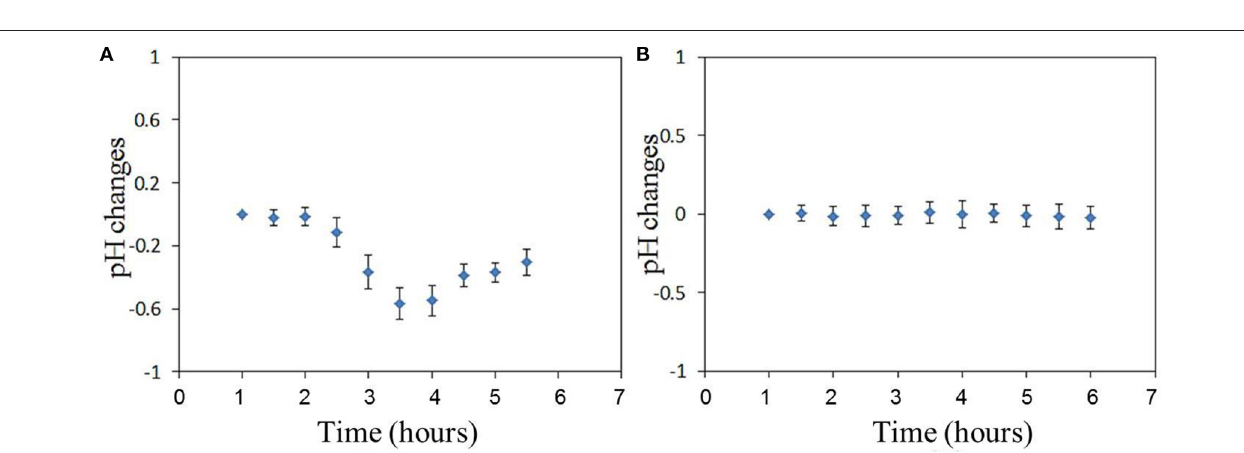
RNP complex involved with aiding viral genome replication, detection of PB1 protein within the nucleus of an infected cell is expected. We marked the cells which have been utilized in